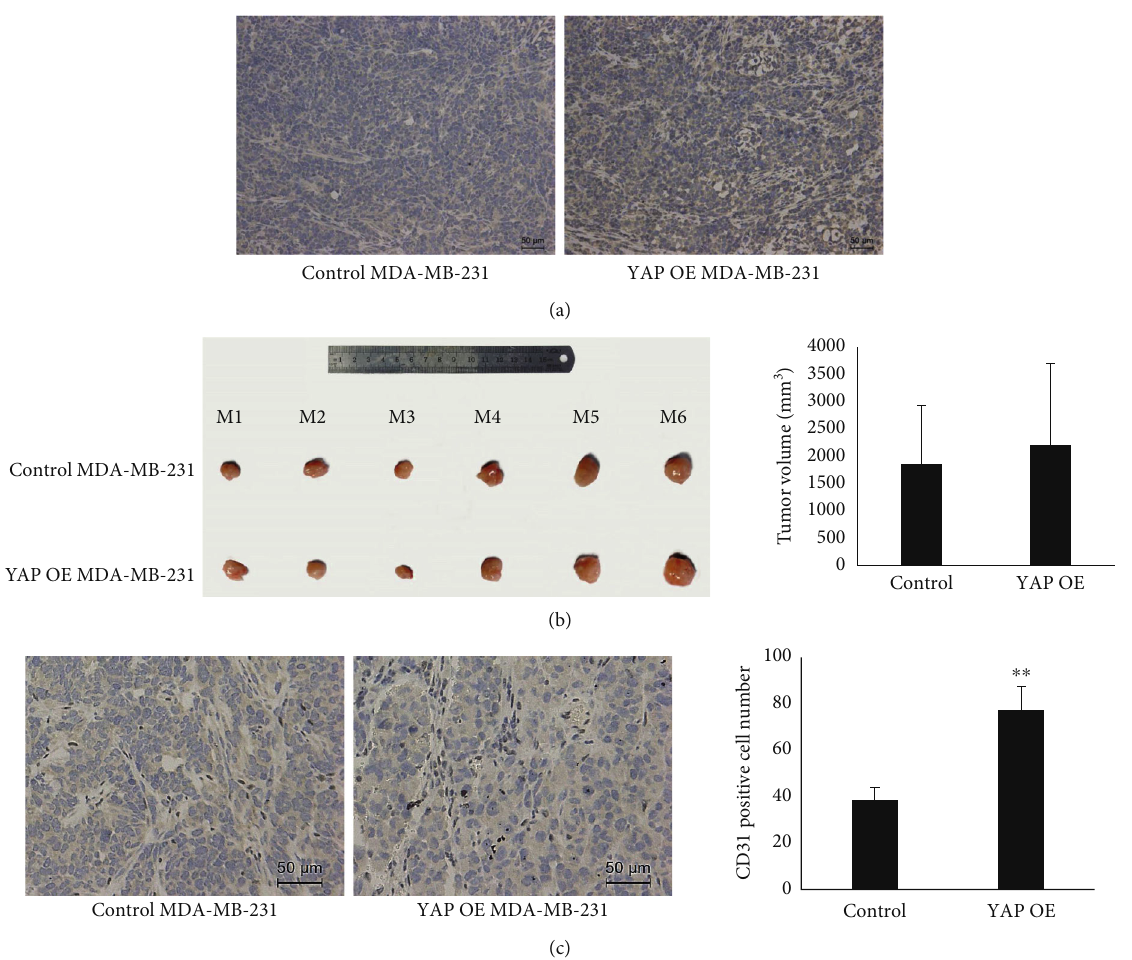
Figure 6: Overexpression of YAP in breast cancer cells promotes angiogenesis in vivo. (a) YAP expressed in di ff erent tumors detected by IHC. (b) Tumor volume was recorded and presented as mean ± SD . (c) CD31 positive cells (dark brown) were detected by IHC in tumors with di ff erent YAP expression. Cell number was recorded and presented as mean ± SD from six independent representative fi elds per tumor. ∗∗ p < 0 : 01